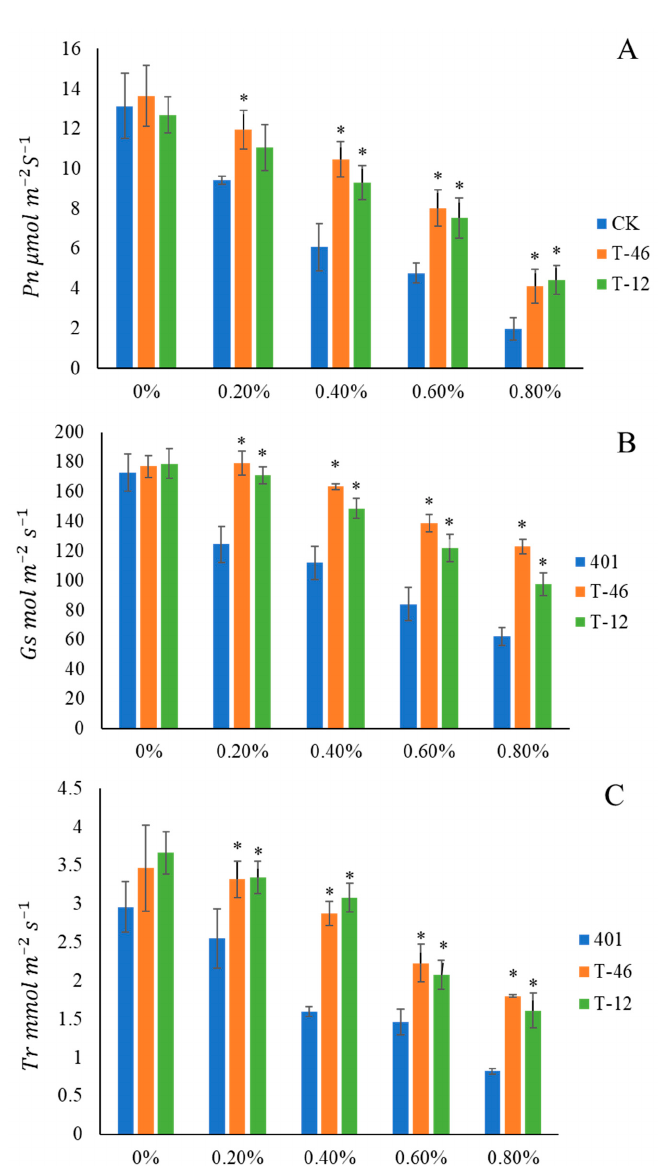
Figure 4. Variations in photosynthesis parameters after NaCl treatment, net photosynthesis rate, Pn ( A ); stomatal conductance, Gs ( B ); transpiration rate, Tr ( C ); “*” denotes a significant difference ( p < 0.05, α = 0.05) between treatments. Error bars represent the standard deviation.